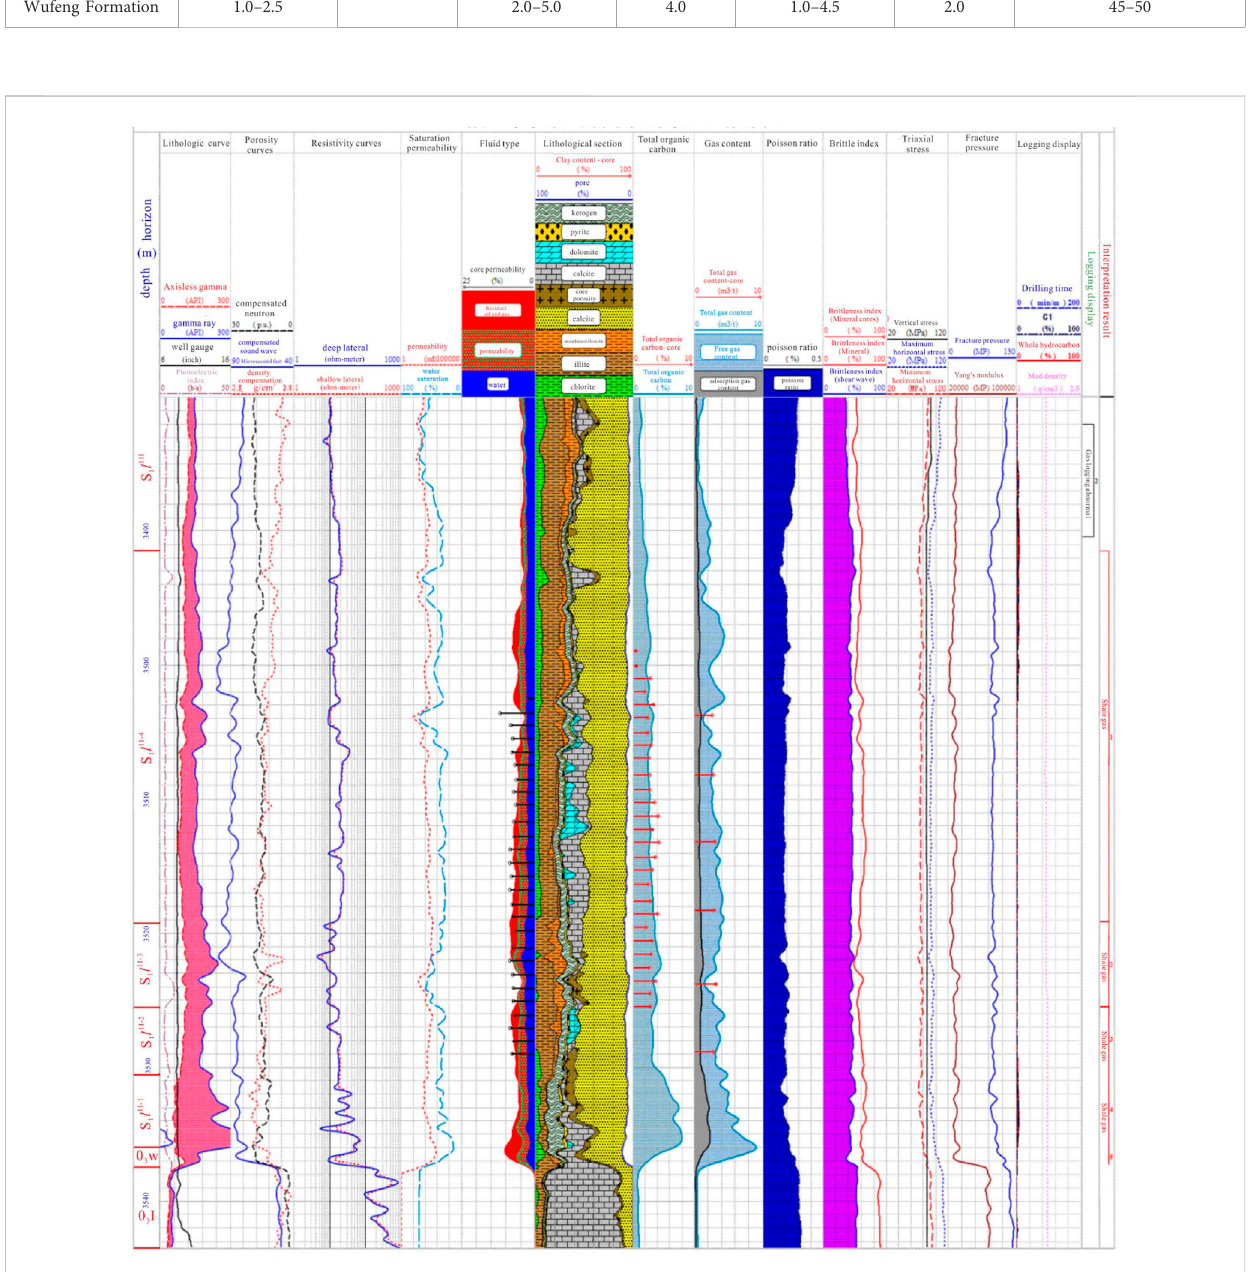
FIGURE 3 Logging curve characteristics and results of well